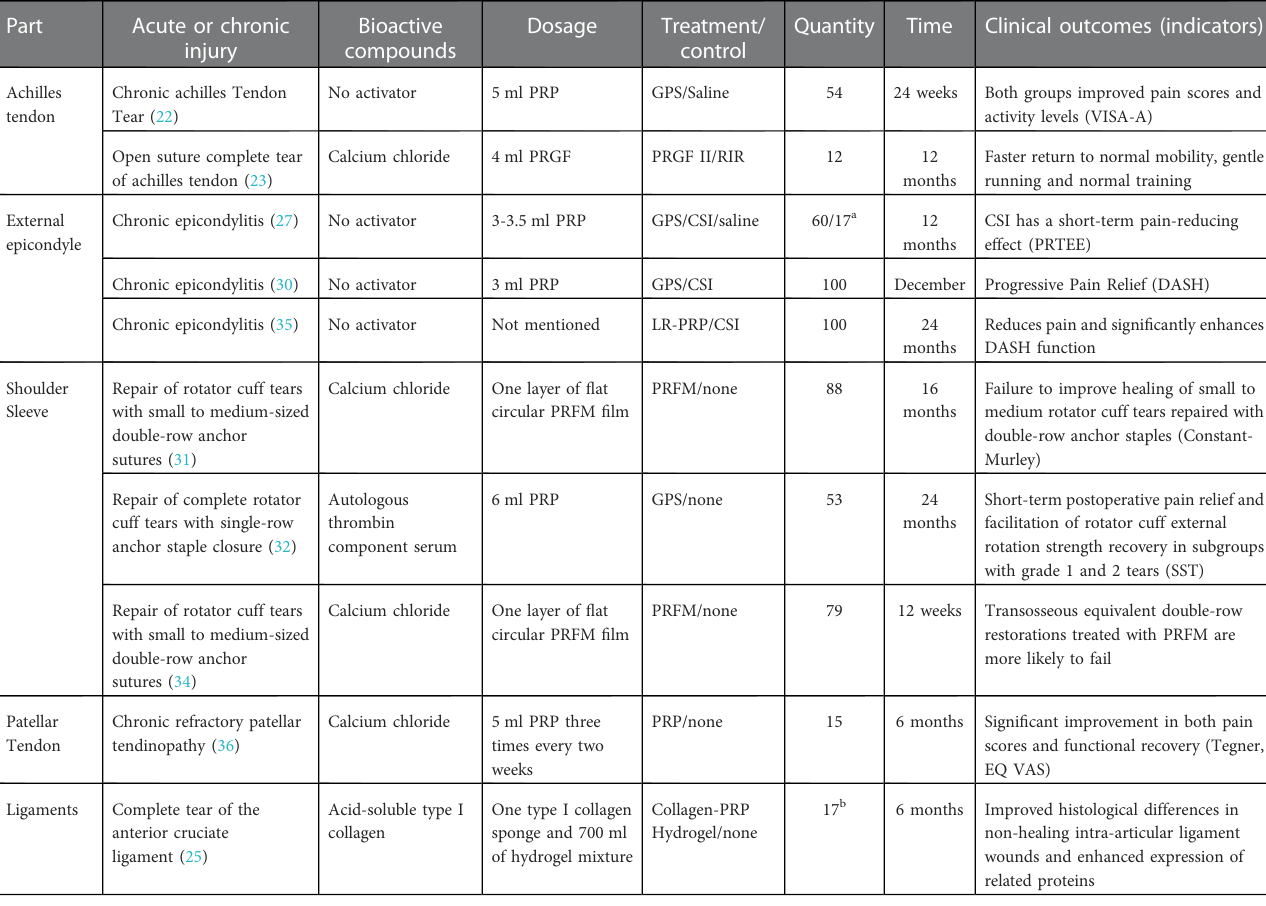
TABLE 7 Additional bioactive compounds, dose, therapy, quantity, duration and clinical outcomes of PRP in the adjunctive treatment of tendon ligament healing. Part